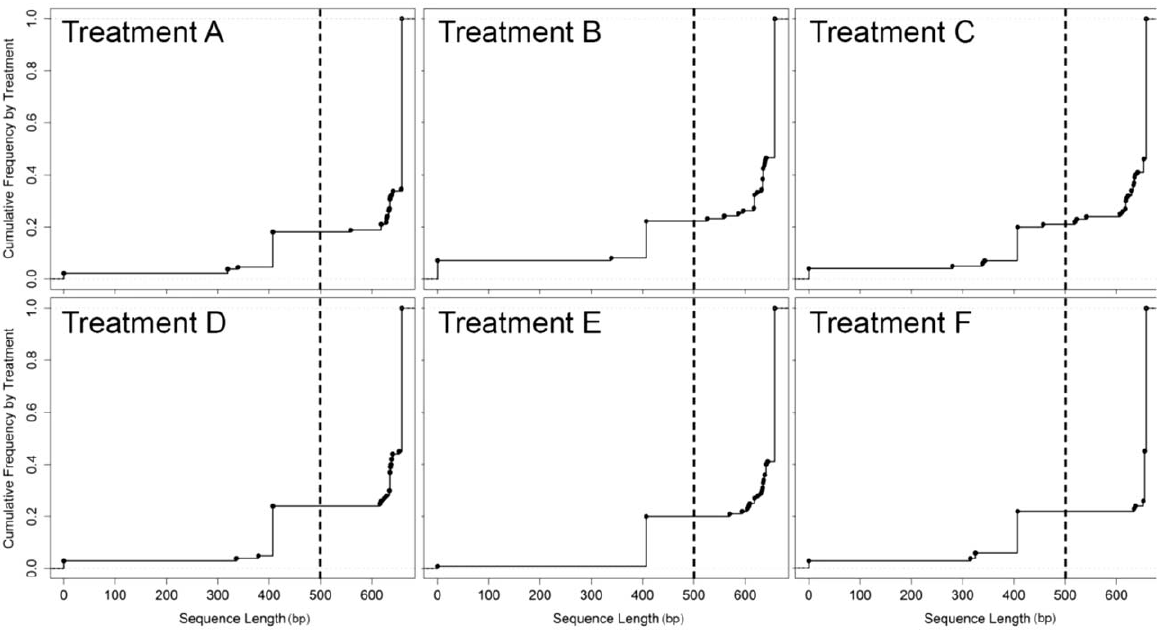
Figure 2. Cumulative frequency graphs of sequence length (base pairs) by treatment. Circles represent the points at which additional sequences are accumulated. Dashed horizontal lines represent the cutoff between partial barcodes (to the left) and full barcodes (to the right).